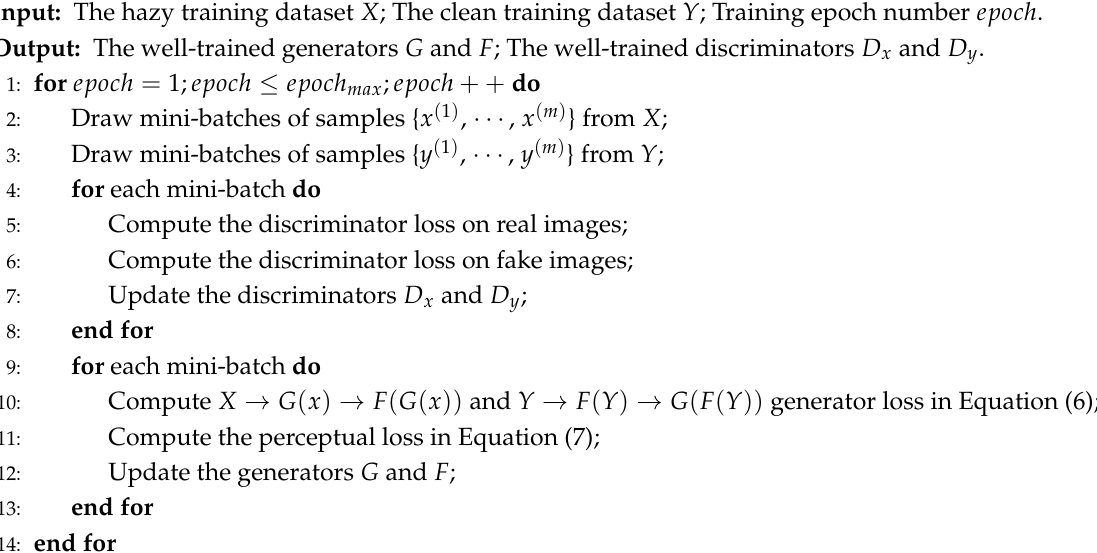
Algorithm 1 OWI-DehazeGAN training procedure